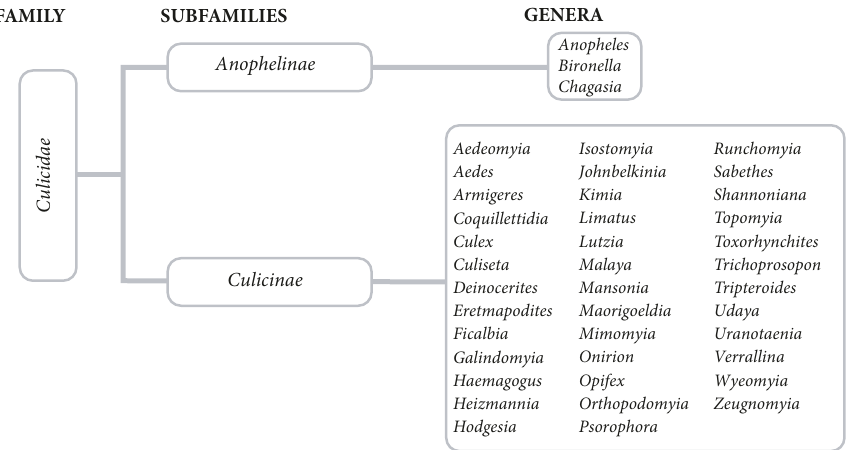
Figure 5: Classification of mosquitoes (DIPTERA: CULICIDAE) (by El Hadji Amadou